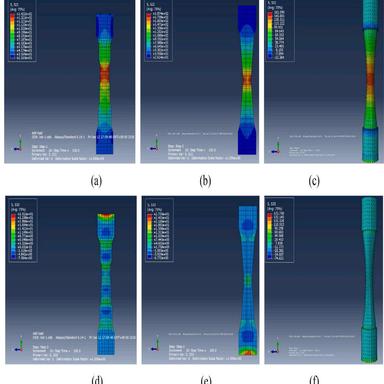
Stress distribution of different specimens during creep by finite element analysis. (a) (d) Variable sections specimen; (b) (e) Trapezoid-section specimen; (c) (f) Arc-section specimen. (a)-(c) Stress distribution of orientation; (d)-(f) Stress distribution of orientation.